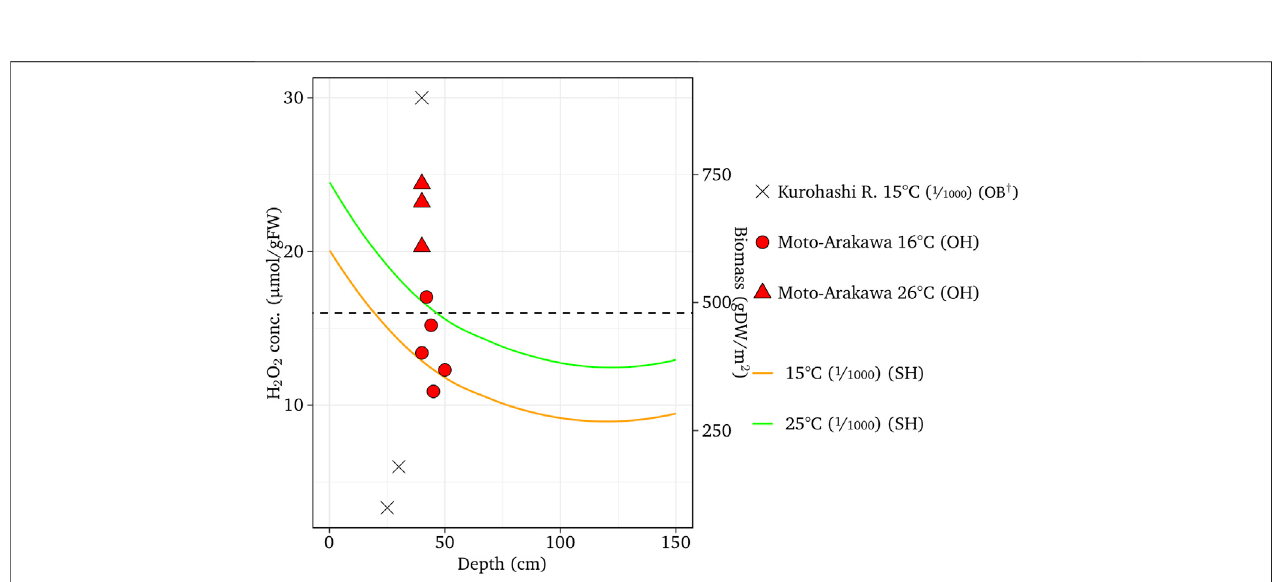
FIGURE 9 | Simulated H 2 O 2 concentrations with different temperatures compared with the observed results for E. nuttallii compared with observed data. † (cid:2) Takahashi et al. (2014); ‘ OH ’ and ‘ SH ’ designate observed and simulated H 2 O 2 , respectively. The fractions in the parentheses are channel slopes.